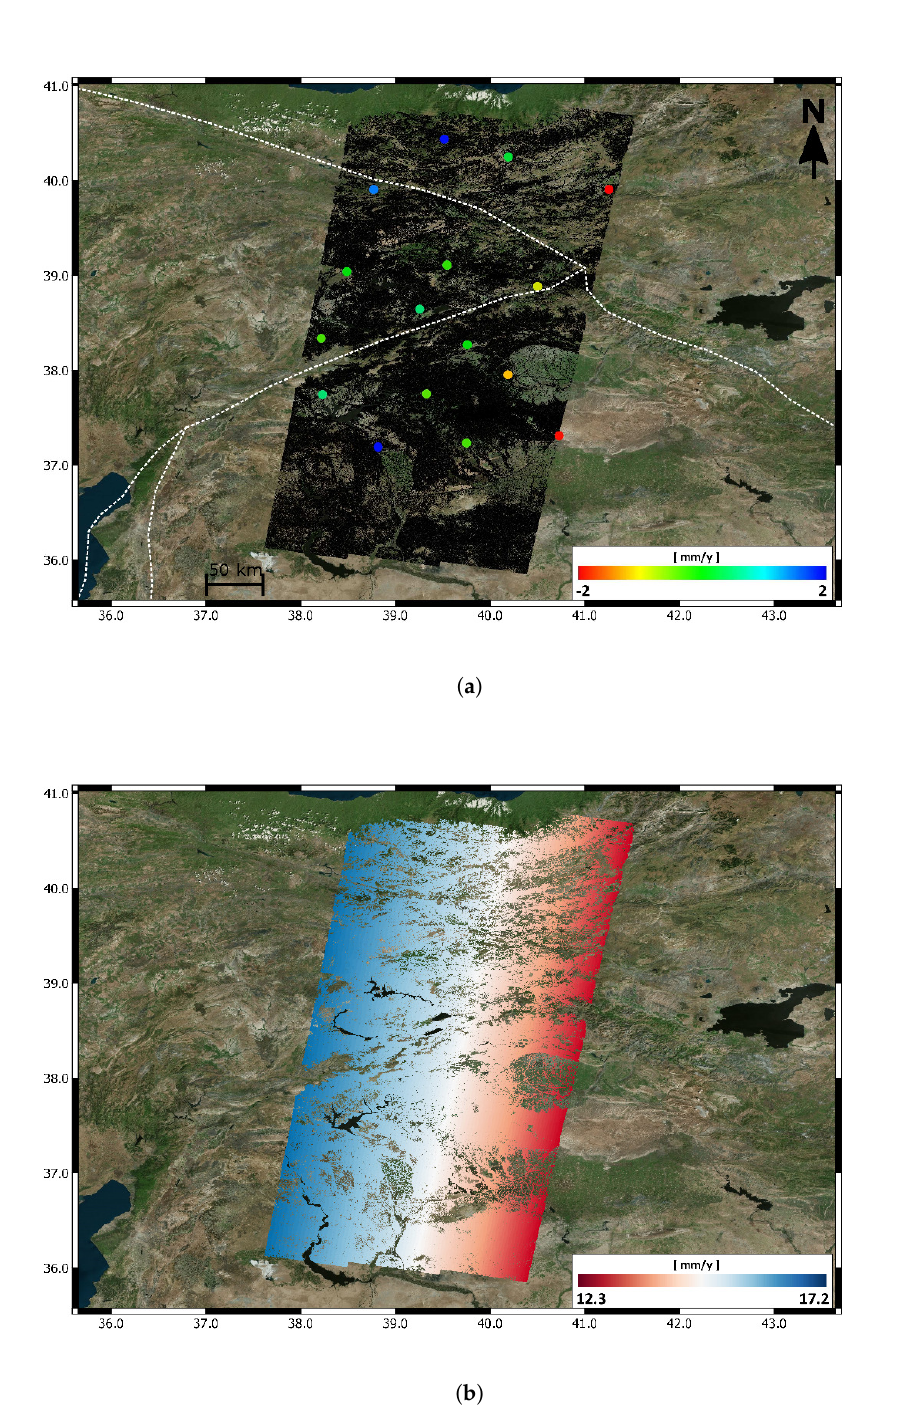
Figure 11. Results for the North Anatolian Fault, showing ( a ) the measured and color-coded ∆ 0 and ( b ) the removed continental drift